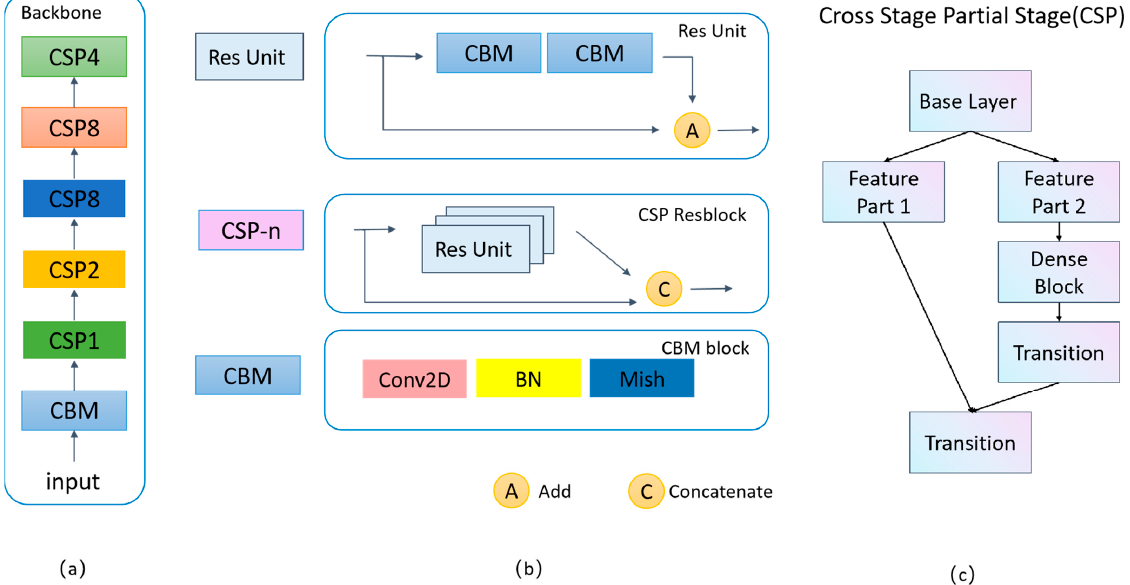
Figure 3. ( a ) Backbone of the StrMCsDet. ( b ) Details of each block. ( c ) The feature fusion strategy in the cross stage partial layer is partial dense block and a transition block is contained in the block, transition at the first and then concatenation and transition at the last.